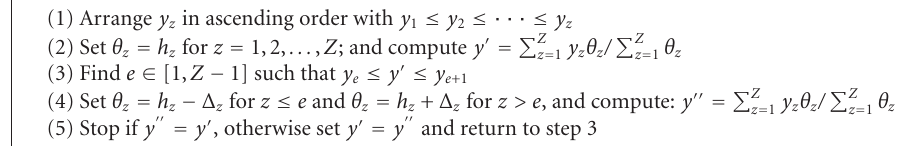
Algorithm 1: Karnik-Mendel algorithm to compute y t r